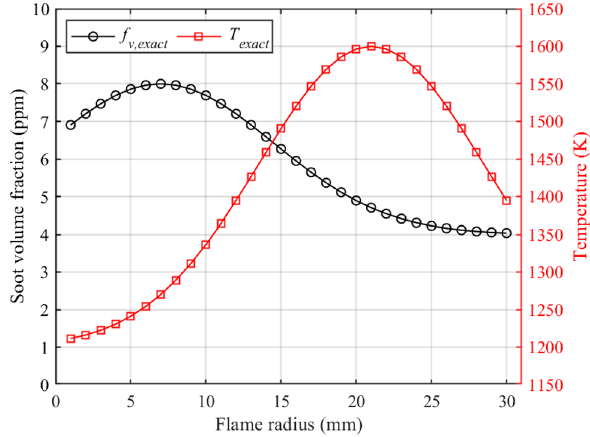
Figure 4. Input distributions of soot volume fraction and temperature.